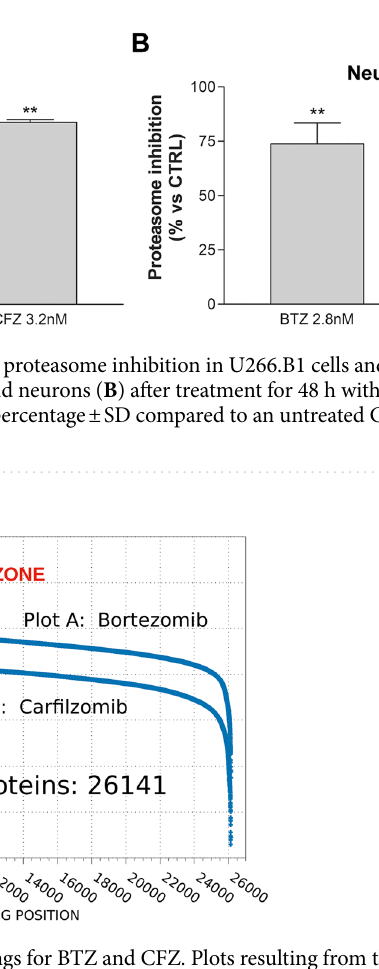
Figure 5. SPILLO-PBSS screenings for BTZ and CFZ. Plots resulting from the in silico screenings carried out for BTZ (Plot A) and CFZ (Plot B) on the available structural proteomes (26,141 protein 3D-structures retrieved from the RCSB PDB in August 2019, excluding 100% sequence identity redundancies) of Homo sapiens , Mus musculus , and Rattus norvegicus . Proteins are ranked in decreasing order according to their score. Tubulin (PDB code: 3RYC) was identified as a potential off-target for BTZ (4th position), but not for CFZ (835th position), which could account for the different neurotoxic profile of the two drugs (plots drawn using gnuplot 15